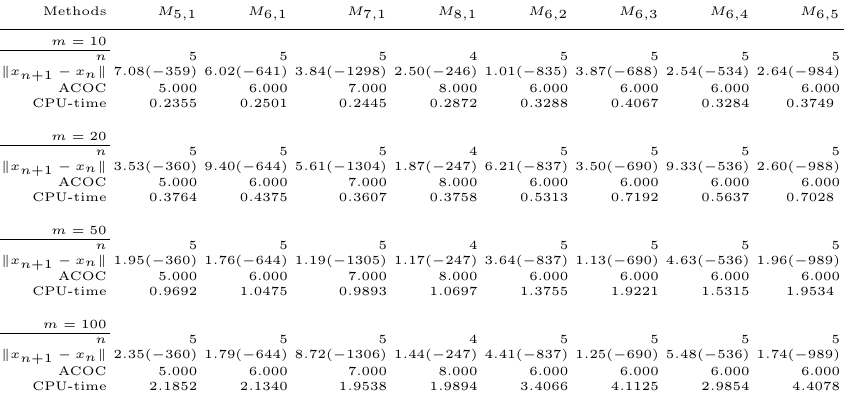
Table 6. Comparison of performance of methods for Problem 3